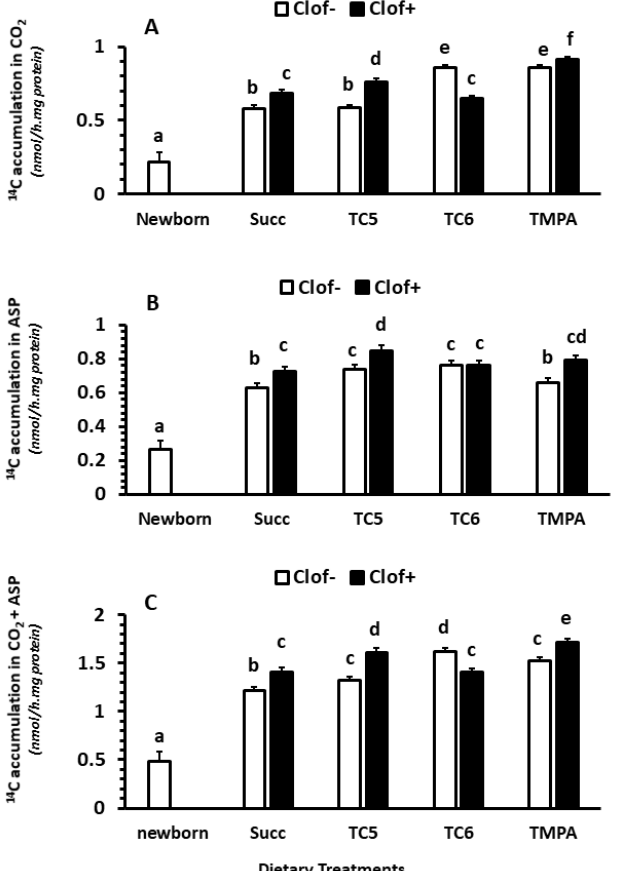
Figure 1. The effect of clofibrate and MCTs on intestinal fatty acid oxidation. Clof: clofibrate; Succ: Succinate + glycerol; TC5: tri-valerate; TC6: tri-hexanoate; TMPA: tri-2-methylpentonoate; ASP: acid soluble products. Data are 14 C accumulations in CO 2 ( A ), ASP ( B ), and CO 2 + ASP ( C ). abcdef denotes significant ( p < 0.05) differences between groups. Values are least square means (n = 6) ± SEM (Standard error means).